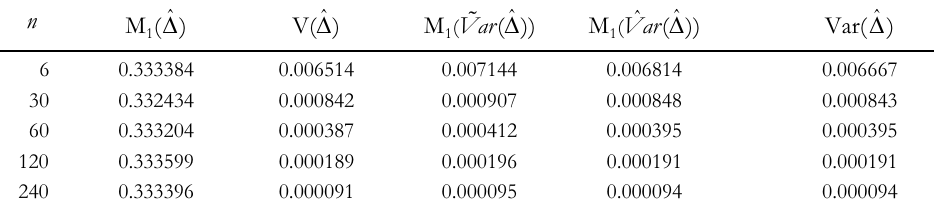
Simulation data for the estimation of )ˆ Var( (cid:39) by )ˆ sampling from the rectangular distribution (B=5000 samples)